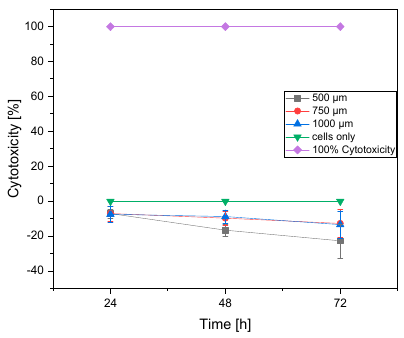
Figure 8. Lactate dehydrogenase (LDH) activity of MG-63 cells on the samples measured after 24, 48 and 72 h (normalized to cell control = cells only) .